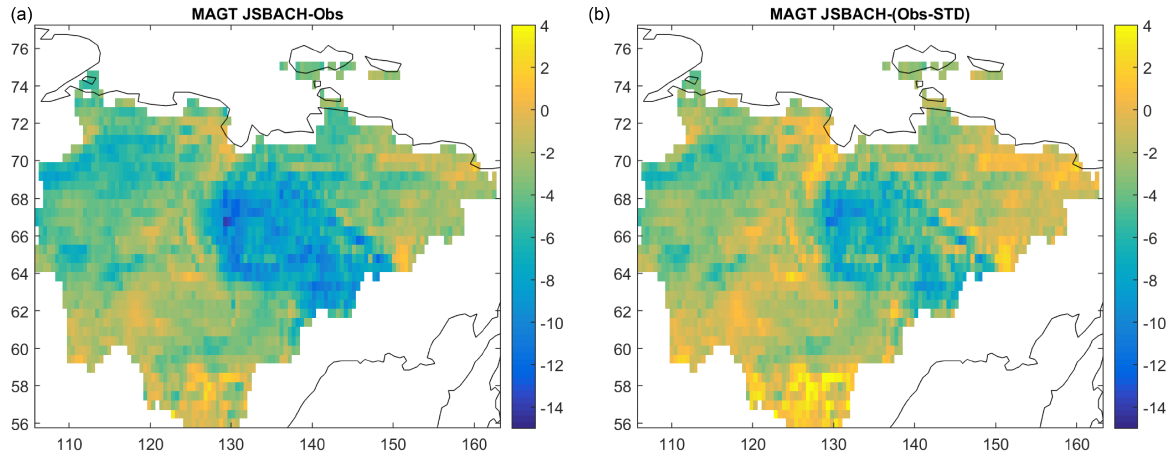
Figure 3. Difference in subsoil temperature ( ◦ C) between the JSBACH model (1960–1990 average) and the Geocryological Map of Yakutia (Beer et al., 2013a). JSBACH results from 38m depth. The right-hand-side figure shows the difference to MAGT mean minus standard deviation (spatial uncertainty) from the Geocryological Map of